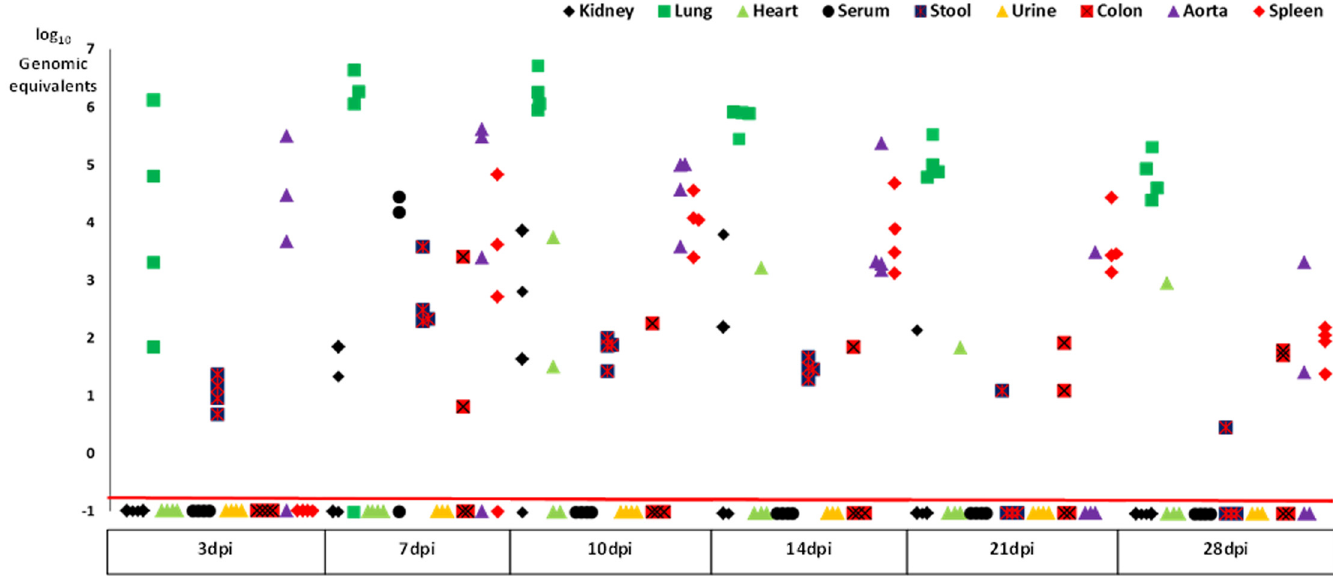
Fig 1. Dot plot of organ-specific viral loads in mice infected by the nasal route expressed as log 10 viral genomic equivalents/mg wet weight for solid organs and copies/mL for body fluids. Samples plotted below the horizontal orange line had no detectable viral DNA.